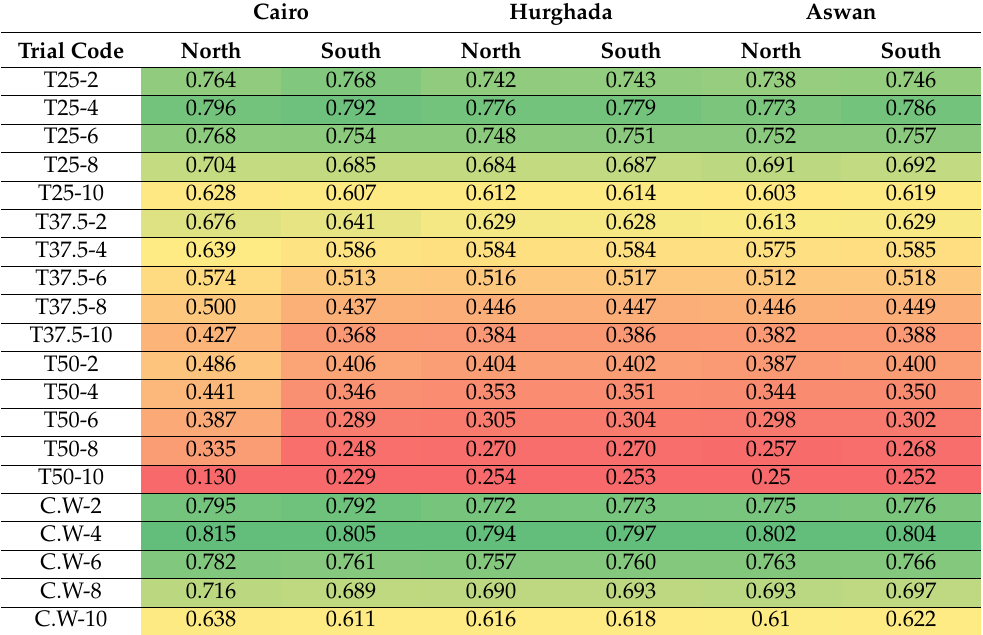
Table 5. The scores for all opaque alternatives in the overall normalized scenario.